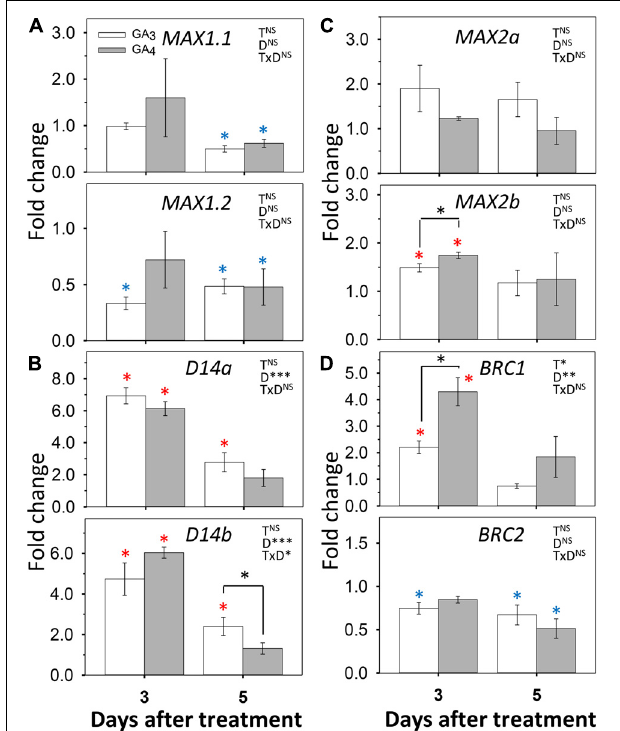
FIGURE 7 | Effect of GA 3 and GA 4 on selected SL-pathway genes in AXBs. AXBs on single-node cuttings were fed with or without GA 3 and GA 4 at concentration of 10 µ M. Gene expression was analyzed after 3 and 5 days of treatment. (A) MAX1.1 and MAX1.2. (B) D14a and D14b. (C) MAX2a and MAX2b. (D) BRC1 and BRC2 . Values are calculated relative to control and represent the means of three biological replicates ± S.E. ( n = six plants). The significance of factors in two-way ANOVA (T, treatments; D, duration in days; TxD, interaction) are indicated by asterisks (* P < 0.05; ** P < 0.01; and *** P < 0.001). Asterisks above the bar indicate decrease (blue) or increase (red), relative to control, and above the hook differences between GA 3 - and GA 4 -treatments (Fischer’s LSD post hoc analysis; P -value at least <